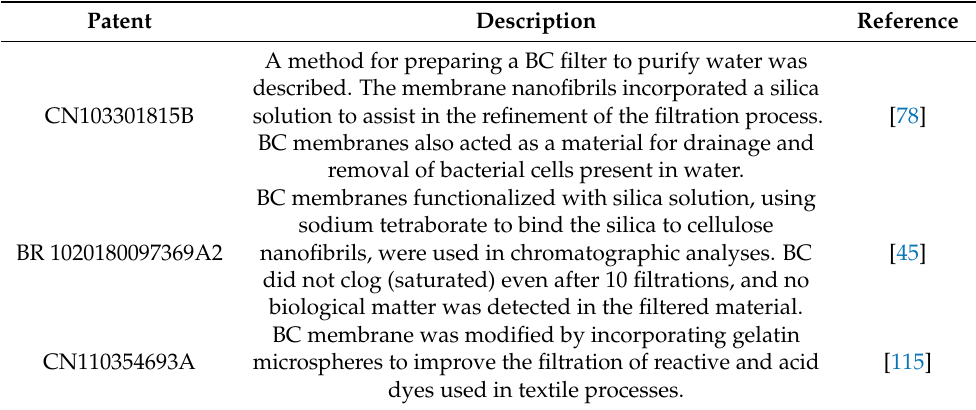
Table 5. Patents filed on the use of bacterial cellulose membranes (BC) as porous bed for the separation of water–oil